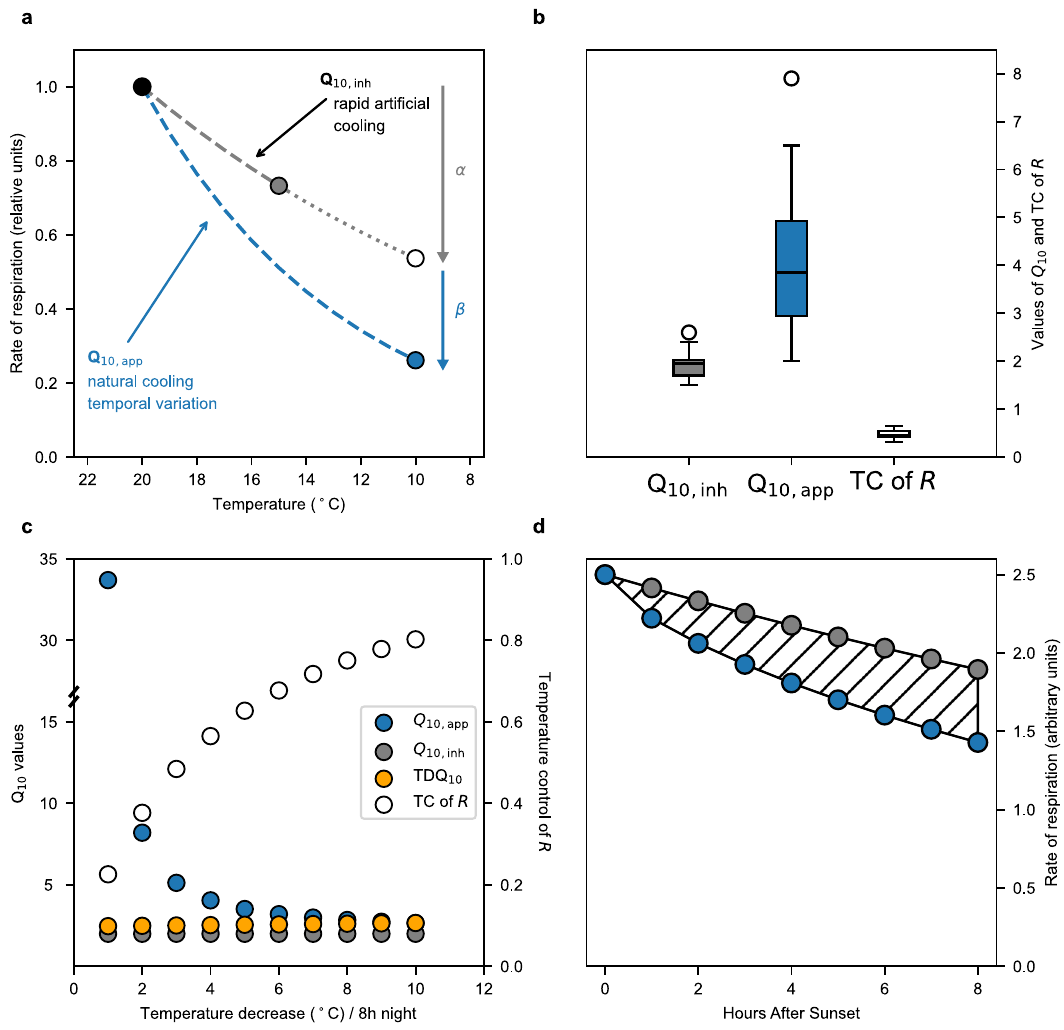
Fig. 2 | Concepts explained. a Conceptual fi gure of how R T (rate of respiration at varying temperature) is measured in response to either (i) common short-term rapid arti fi cial cooling (e.g. during 10 – 30min) of leaf/plant can be used to calculate Q 10,inh (inherent temperature sensitivity of R , Equation 1, using point connected by the grey dashed line), or (ii) natural cooling (over several hours) of the environment along temporal variation in T can be used to calculate Q 10,app (apparent temperature sen- sitivity of R , Equation 1, using the points connected by the blue dashed line). The decrease in R T due to change in T alone is denoted α and the further observed decrease in R is denoted β . Common practise is also to extrapolate (represented by a short-dashed curve) how R T is assumed to change (open symbol) with T-change further into thenight than the actualmeasured T-change (long dashed curve). b Box- and-whisker plots (The centre line is the median. The lower whisker is the lowest datum above the fi rst quartile − 1.5×interquartile range. The upper whisker is the highest datum below the fi rst quartile − 1.5×interquartile range. Any points outside